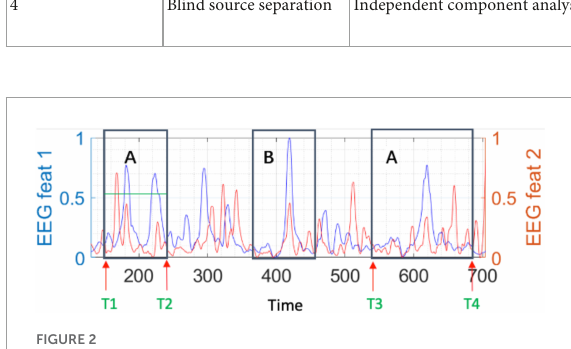
FIGURE2 An illustrative example of the two EEG features (fEEG1 and fEEG2) values over the time for a given code comprehension task, with two specific regions of interest A and